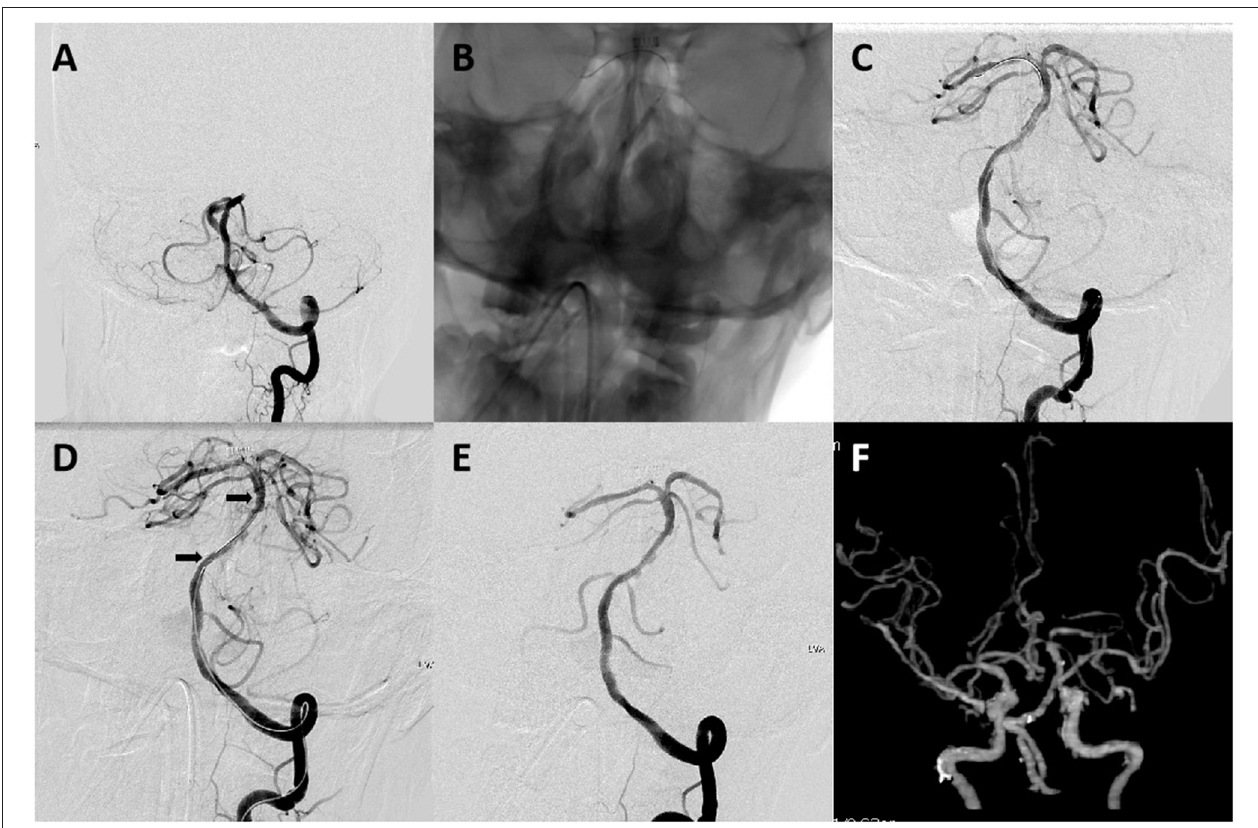
FIGURE 3 | A 64-year-old male patient with acute stroke due to acute basilar artery occlusion. (A) Left vertebral artery angiogram revealed occlusion at the proximal basilar artery. (B) A 2mm × 15mm balloon (gateway) was deployed and inflated in the occluded segment. (C–E) Left vertebral artery angiogram obtained after intracranial angioplasty and stent placement revealed complete basilar artery recanalization and good distal perfusion. Arrows indicate proximal and distal ends of the Enterprise stent (4mm × 22mm). (F) CT angiography on 24-h follow-up revealed a patent basilar artery. The patient had a mRS score of 1 on a 3-month